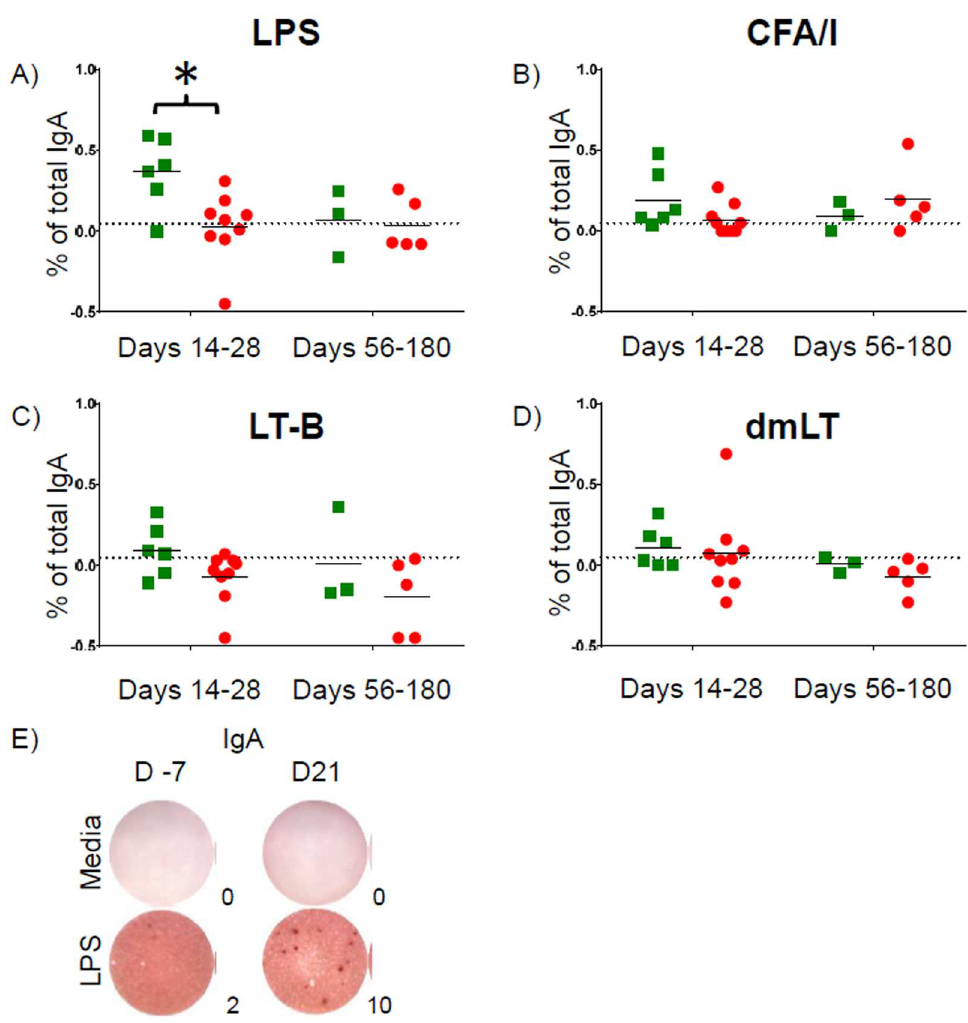
total) indicate responders. E) Representative exampleof B M ELISpots. * p <